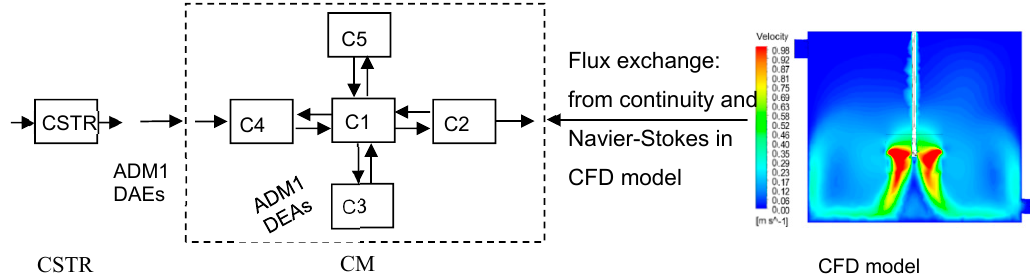
Figure 2. Deriving a compartmental model (CM) from a computational fluid dynamics (CFD) model to build a non-ideal mixing kinetics model.